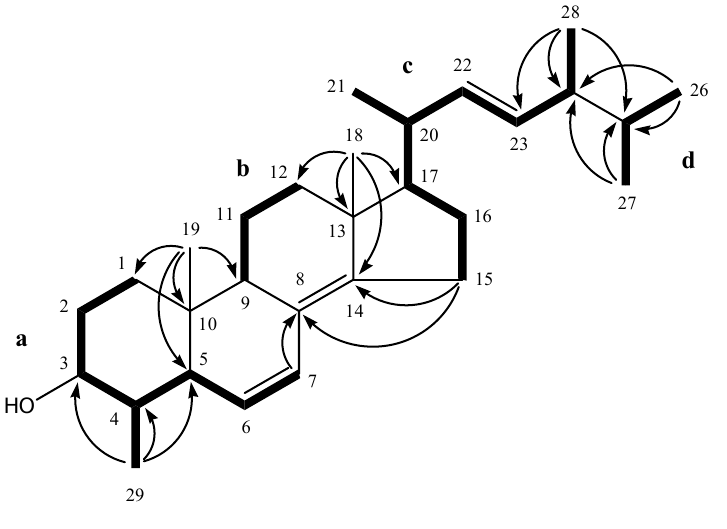
Figure 2. 1 H- 1 H COSY correlations (bold lines) and key HMBC correlations (H → C) of 1